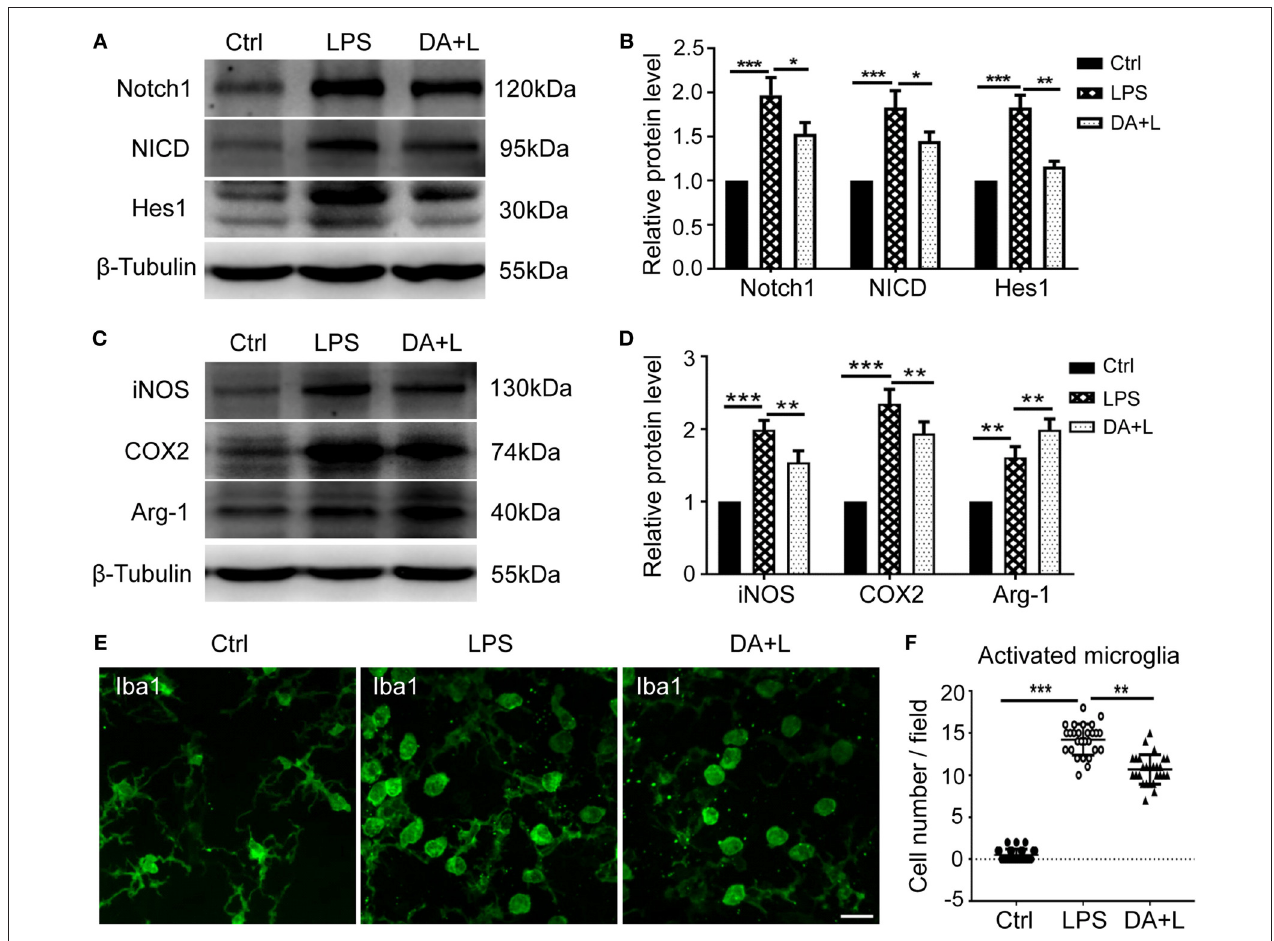
FIGURE 5 | Notch1 signaling modulated activation and polarization of retinal microglia in vivo . (A,B) The protein expressions of Notch1, NICD, and Hes1 were significantly upregulated after LPS stimulation compared with the control. DAPT treatment reduced the increased expressions of Notch1, NICD, and Hes1 induced by LPS. (C,D) The protein expression of iNOS, COX2, and Arg-1 were markedly increased in vivo by LPS stimulation compared with the control. DAPT treatment suppressed the expression of iNOS and COX2, but further enhanced Arg-1 expression. (E) Retinal flat mounts showed that the number of amoeboid microglia in DA + L group was less than that in the LPS group. (F) The dot plots of activated microglia. Total 27 retinal images in each group were used for analysis. * p < 0.05, ** p < 0.01, and *** p < 0.001 (one-way ANOVA). Scale bar, 40 µ m. Ctrl, Control; DA + L, DAPT + LPS.